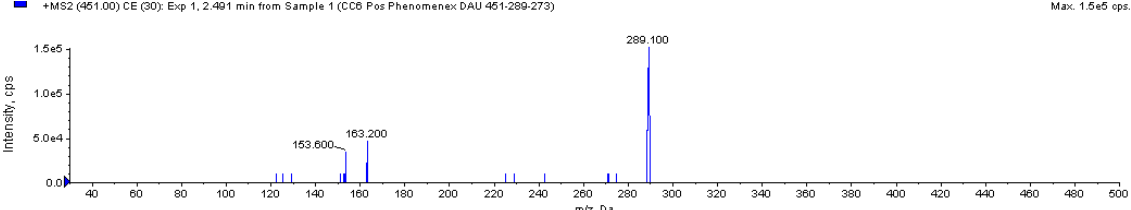
Figure 4. Mass spectrum of the compound with t